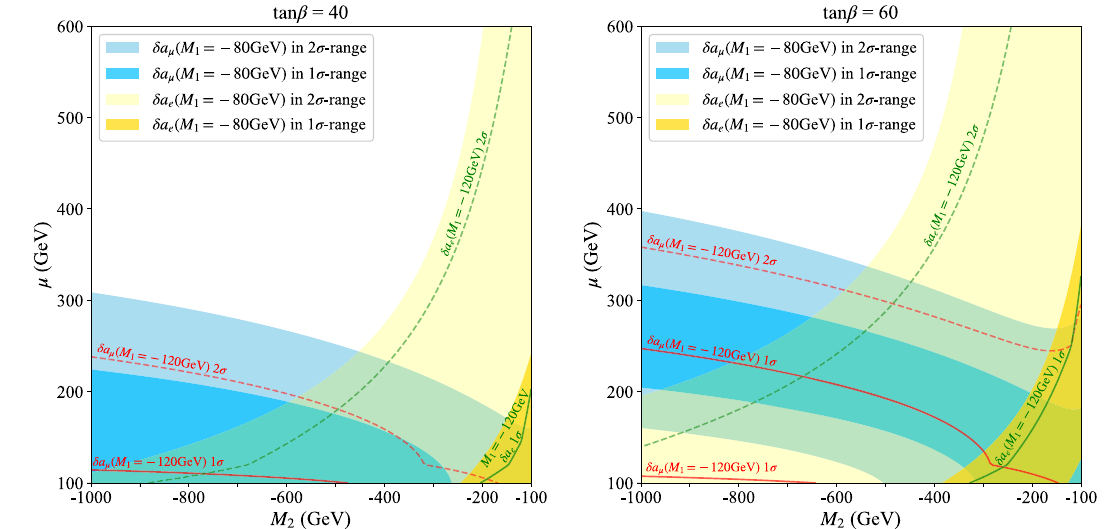
Fig. 1 Contours of δ a SUSY e and δ a SUSY μ on the plane of μ versus M 2 for tan β = 40 (left) and tan β = 60 (right). The colored regions correspond to M 1 = − 80 GeV while the colored curves correspond to M 1 = − 120 GeV. The 1 σ and 2 σ mean to explain (cid:4) a Exp respectively